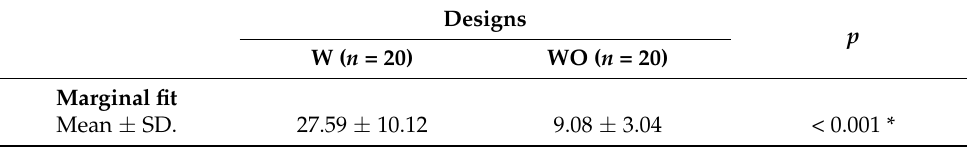
Figure 8. Comparison between marginal fit ( µ m) of the two studied materials. Table 5. Comparison between marginal fit ( μ m) of two studied preparation designs.